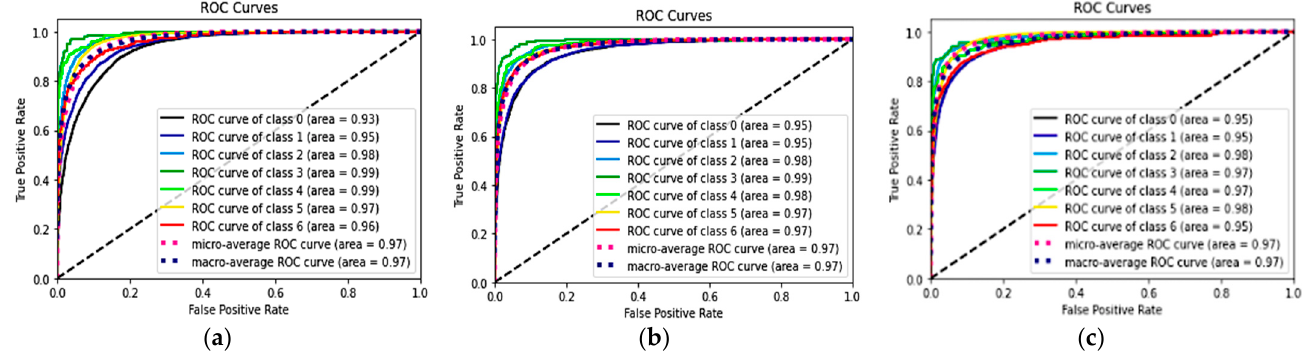
Figure 5. ROC and AUC of the three models: classification alone ( a ), combined method 1 (RelayNet) ( b ), and combined method 2 (graph-cut) ( c ). Table 2. Performance of the three models using the testing set: classification alone, combined method 1, and combined method 2 in the classification of the macular conditions.